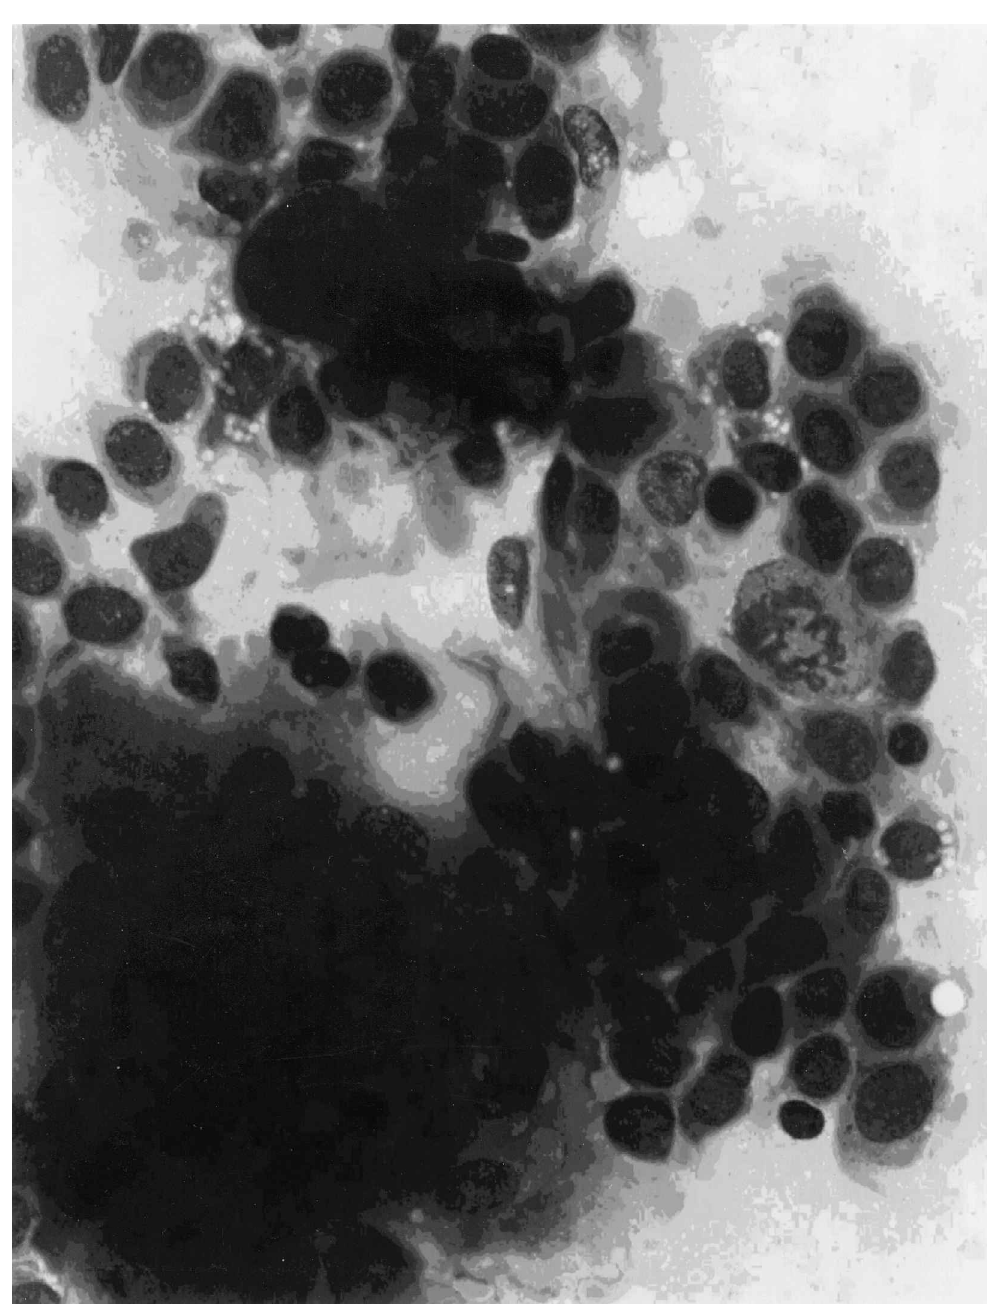
Fig. 4. Cytology of GCT, with cell polymorphism and mitotic (cid:142) gure (MGG, x160).The aspirate was categorised as benign by one of the cytologists and as sarcoma by the